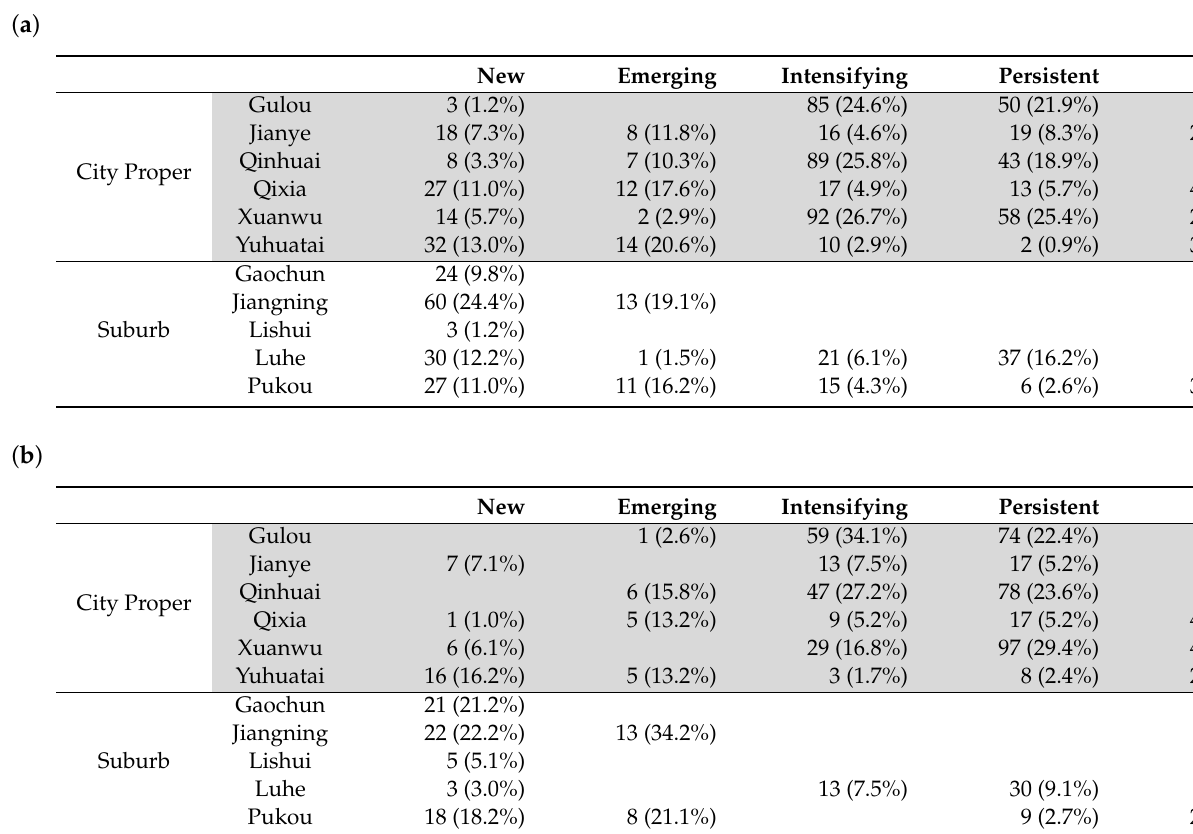
Table 2. Number of fire hot spots within each urban district 2 : ( a ) total fire and ( b ) dwelling